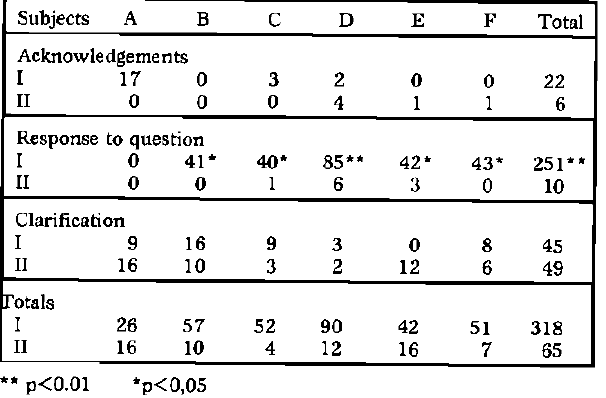
Table 2: Variation within Linguistic Responses for all subjects in Interaction I and II Subjects